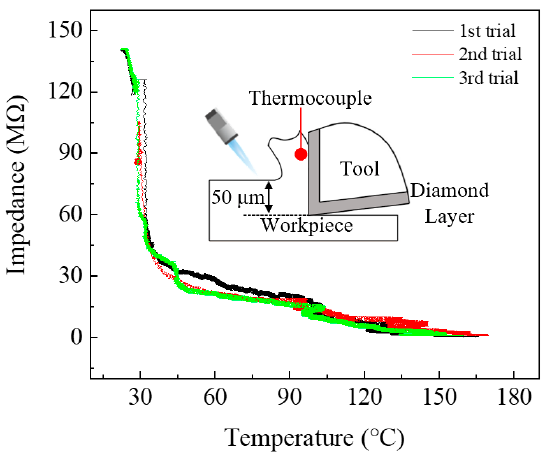
Figure 5. Thermal experiment.